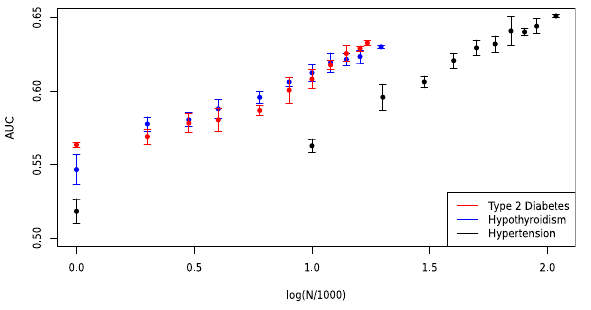
Figure 13. Maximum AUC on out-of-sample testing set (eMERGE) as a function of the number of cases (in thousands) included in training. Shown for type 2 diabetes, Hypothyroidism and